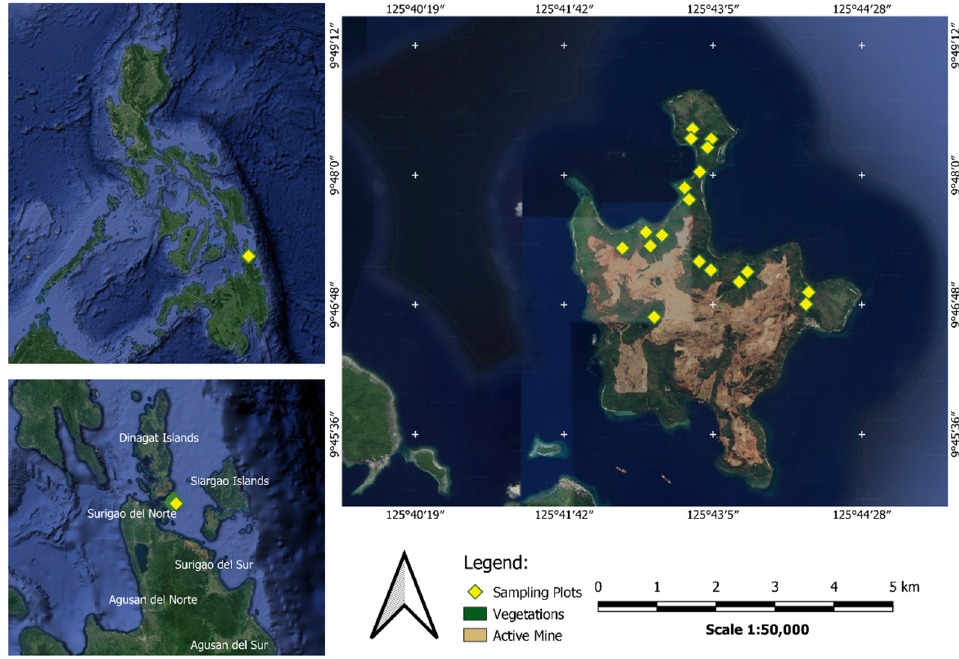
Figure 1. Study location of ultramafic areas with slightly disturbed and disturbed vegetation from mining activities in Hinatuan Island, Tagana-an, Surigao del Norte, Philippines (Google Earth, 2020).